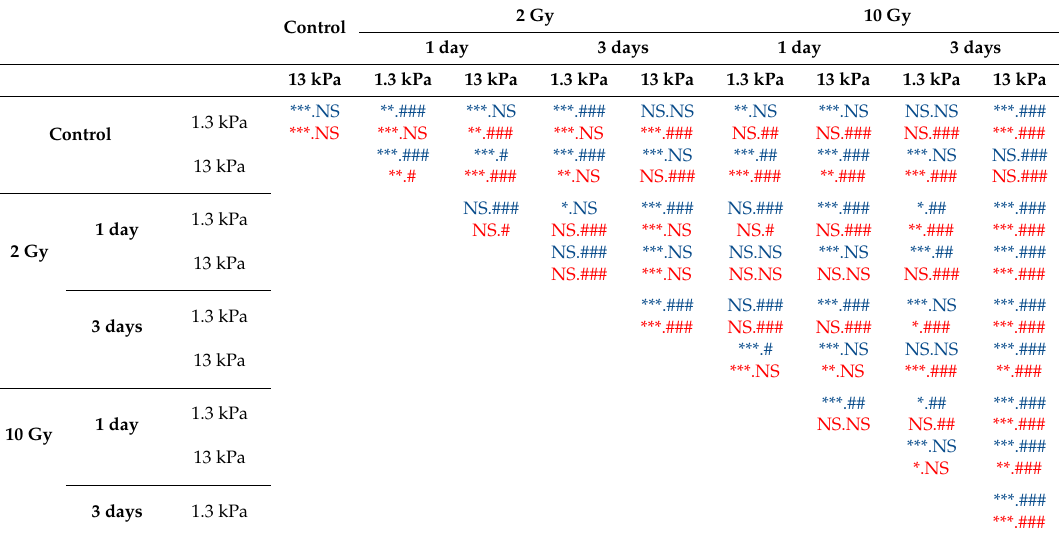
Table 1. Statistical analysis for data of spreading and nuclei